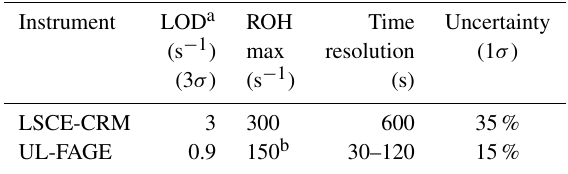
Table 1. Performance of the two OH reactivity instruments de- ployed during the LANDEX